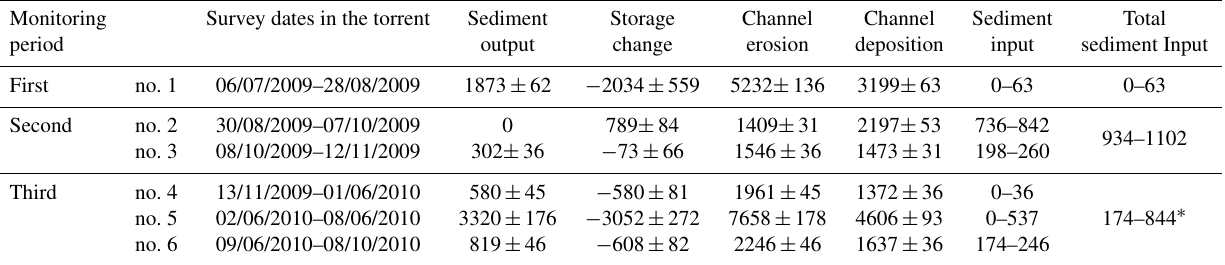
Figure 9. Geomorphic activity revealed by comparing the topographic differences of the two successive TLS surveys operated in November 2009 and July 2010. The sediment budgets for each subcatchment are detailed in Fig. 15. Table 4. Sediment budget (in cubic metres) of the Manival torrent established after noticeable events using the morphological approach after Theule et al. (2012). The torrent recharge (sediment input) is estimated from in-storage changes in channels and volumes deposited in the sediment trap